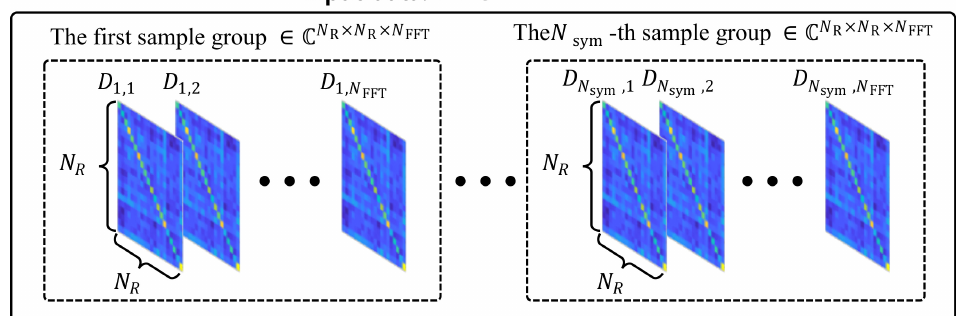
Figure 5. Example of input data.